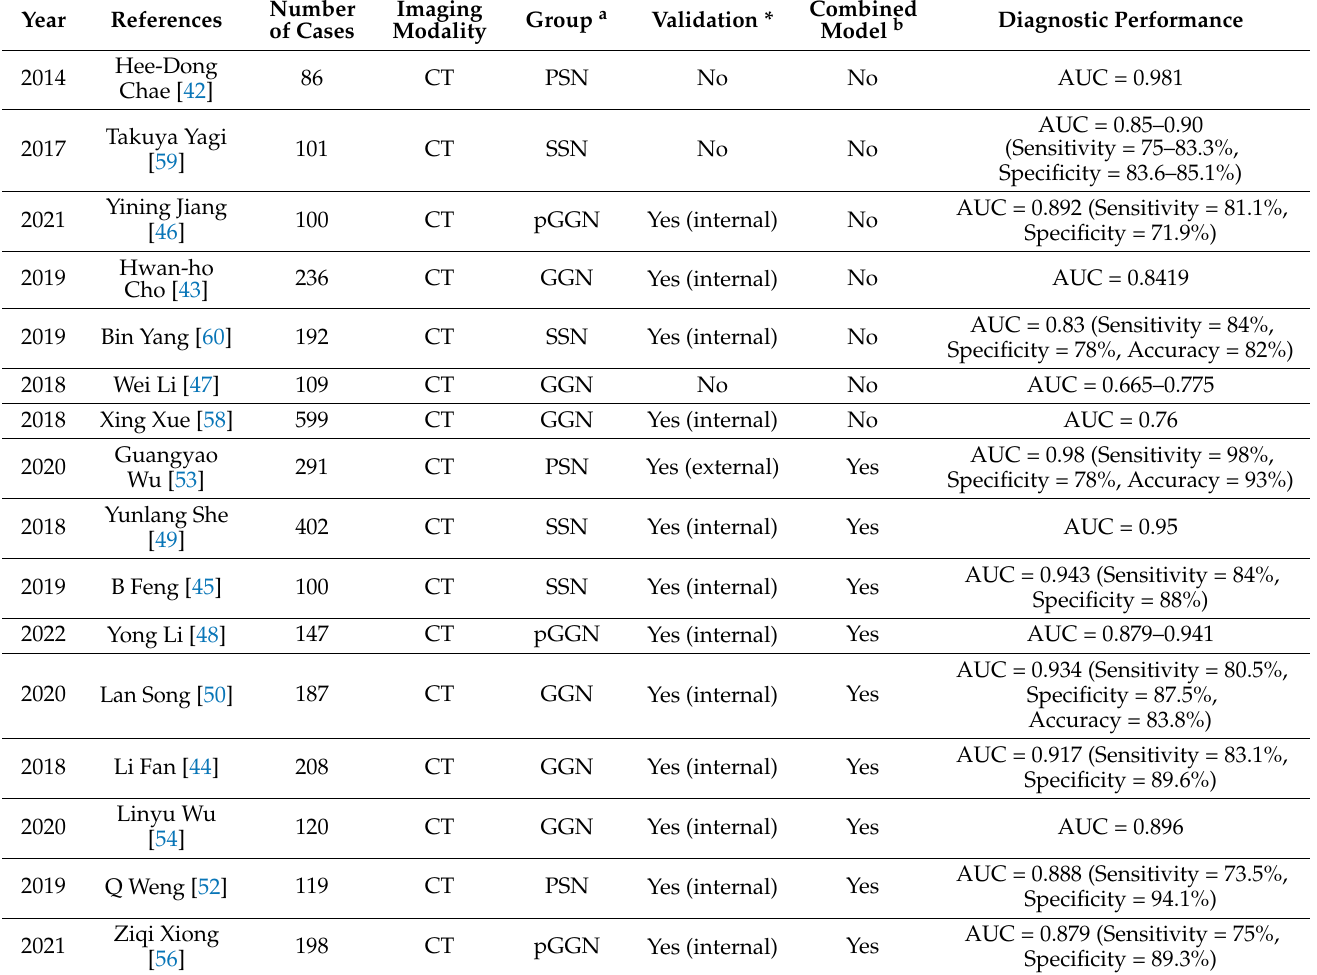
Table 2. Description of studies using different radiomics features to determine the invasiveness of lung adenocarcinoma spectrum